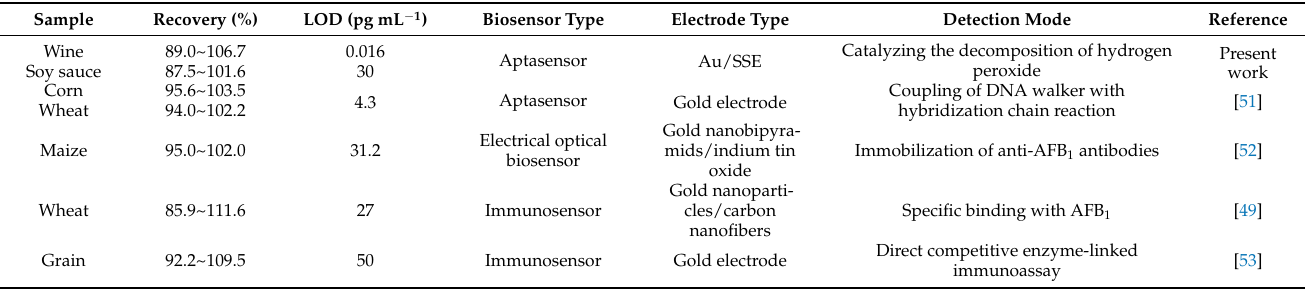
Table 3. Comparison of electrochemical sensors reported in the literature for the detection of aflatoxin AFB 1